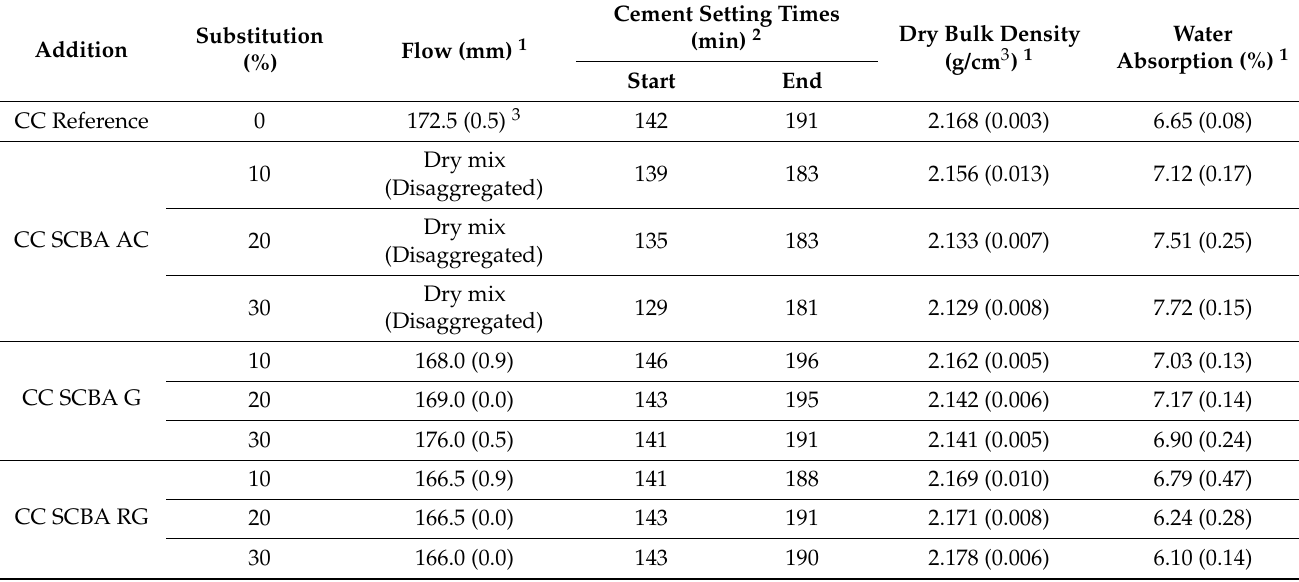
Table 3. Pozzolanic activity of SCBA.